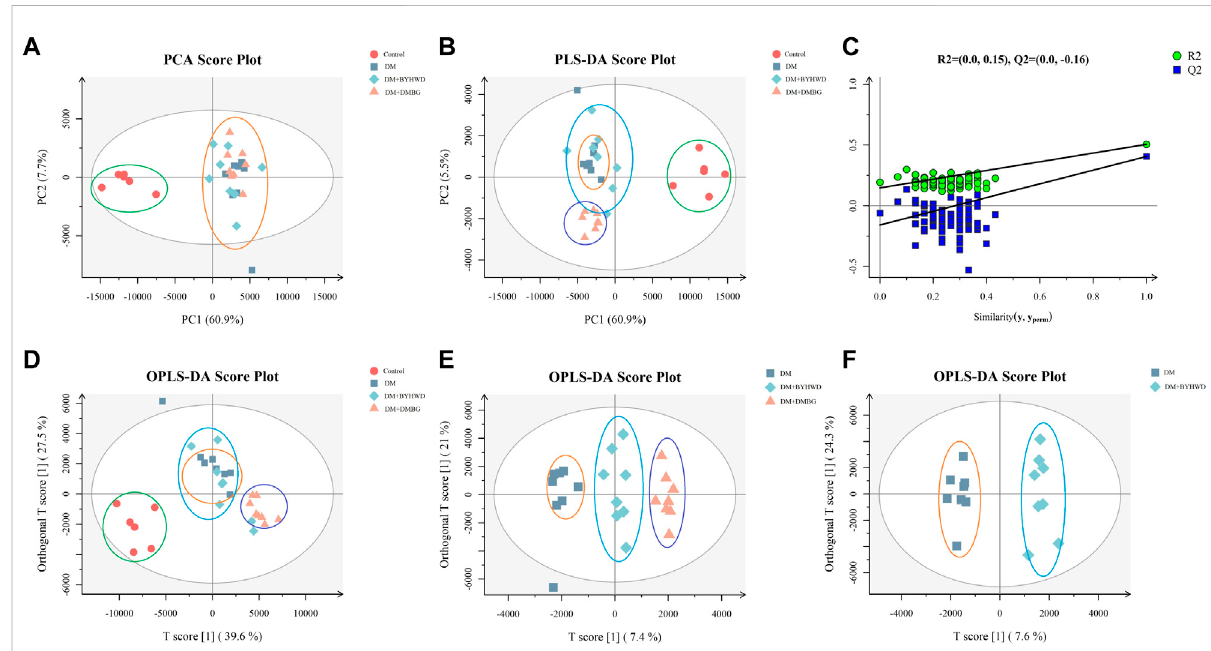
FIGURE 9 BYHWDaffectedthelipidmetabolismdisplayedbymultivariatestatisticalanalysis: (A) PCAplotsofthefourstudygroups; (B) PLS-DAplotsofthe four groups; (C) permutations plots of the four study groups; (D) OPLS-DA plots of the four study groups; (E) OPLS-DA plots of DM, DM + BYHWD, and DM + DMBG groups; (F) OPLS-DA plots of the DM and DM + BYHWD groups. The red circle represents the rat ’ s sample from the control group; the deep-blue square represents the rats ’ samples from the DM group; the light-blue diamond represents the rats ’ samples from the DM + BYHWD group, and the orange triangle represents the rats ’ samples from the DM + DMBG